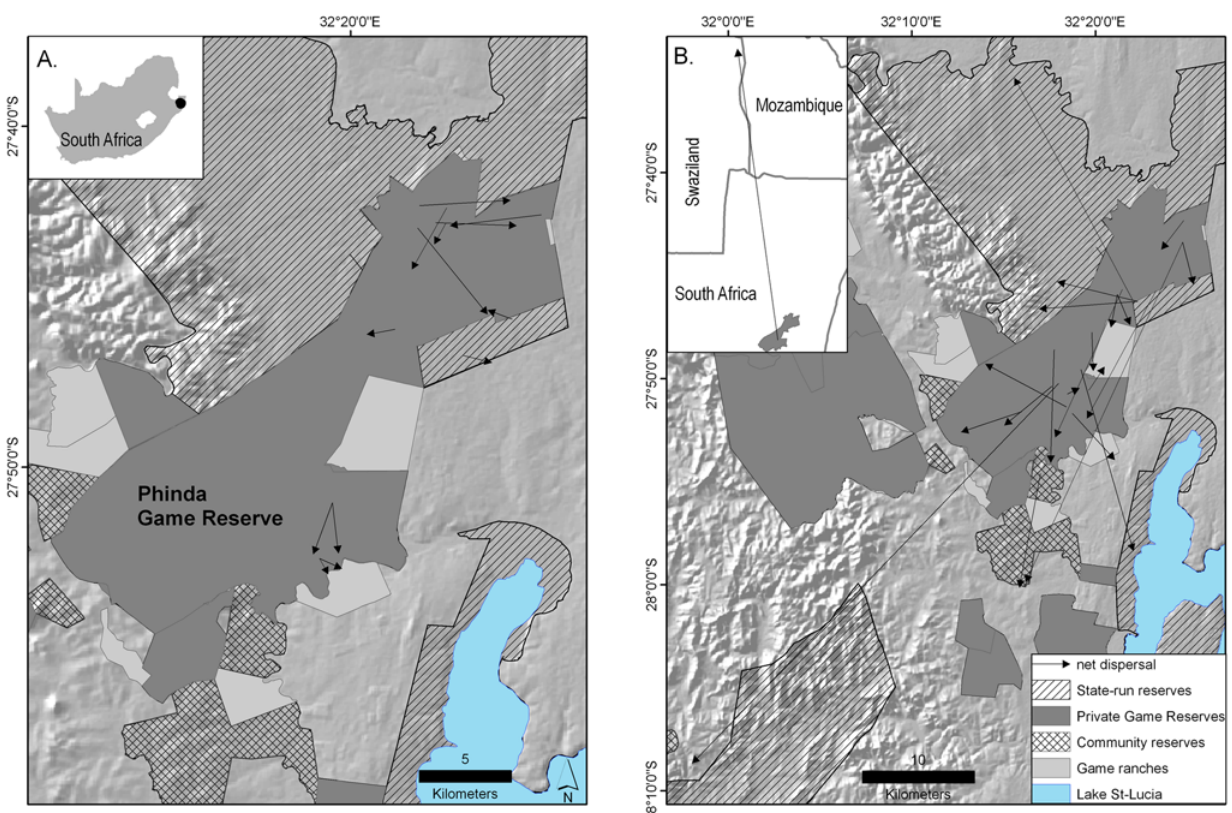
Fig 1. Net dispersal distance of subadult leopards, Phinda Private Game Reserve, South Africa, 2002 – 2012. (a) Subadult females (n = 13), with inset showing the location of Phinda in South Africa, (b) subadult male leopards (n = 22), with inset showing net long-distance dispersal of male M67 to north- eastern Swaziland.